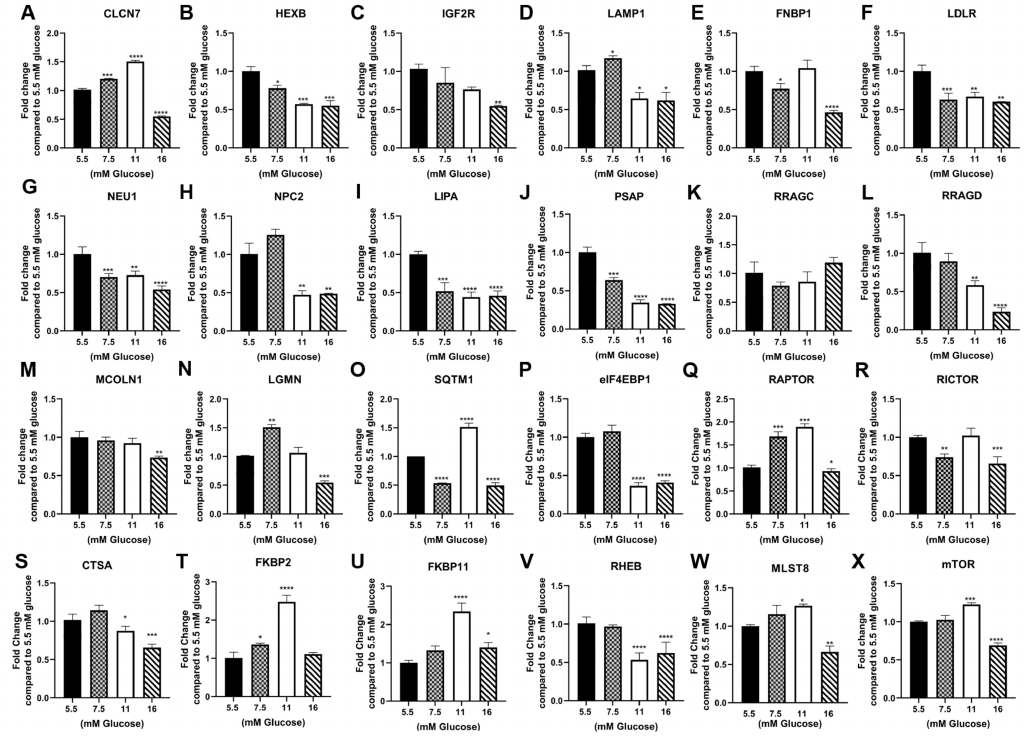
Figure 3. Expression of lysosomal and mTOR genes in HREC24T cells treated with 5.5 mM, 7.5 mM, 11 mM and 16 mM glucose for 7 passages. RT-qPCR analysis of ( A ) CLCN7; ( B )